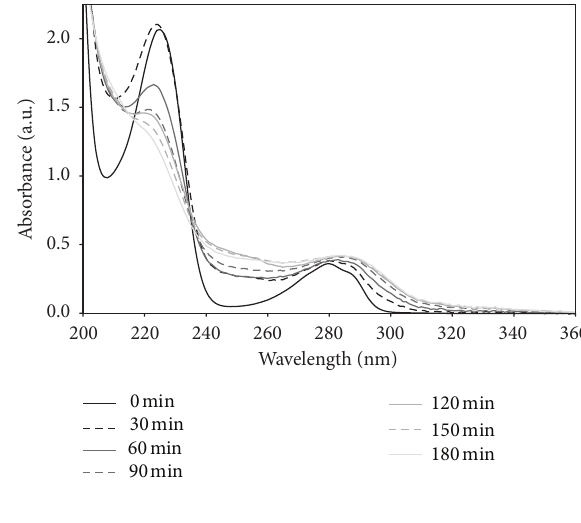
Figure 8: UV/Vis spectra of the 4CP degradation under photolysis.